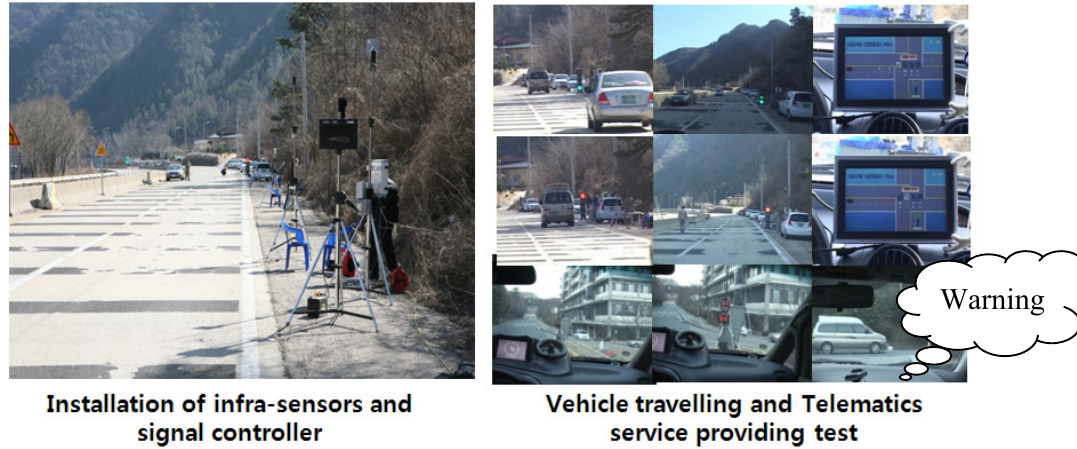
Figure 7. Signalized intersection test: red-light violation warning at signalized intersection.